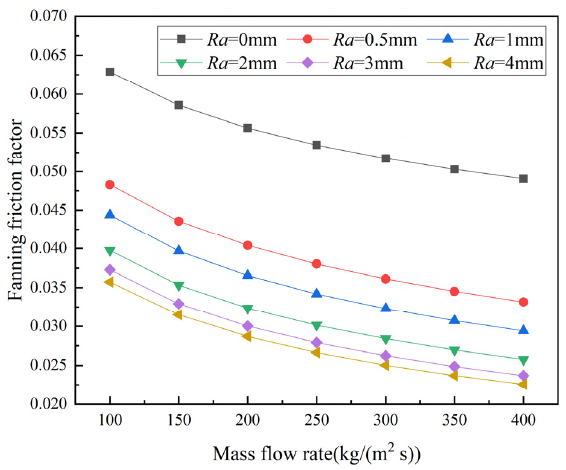
Figure 10. Fanning friction factor values of PCHEs at different mass flow rates for different curvature radii of inserted arc segments.